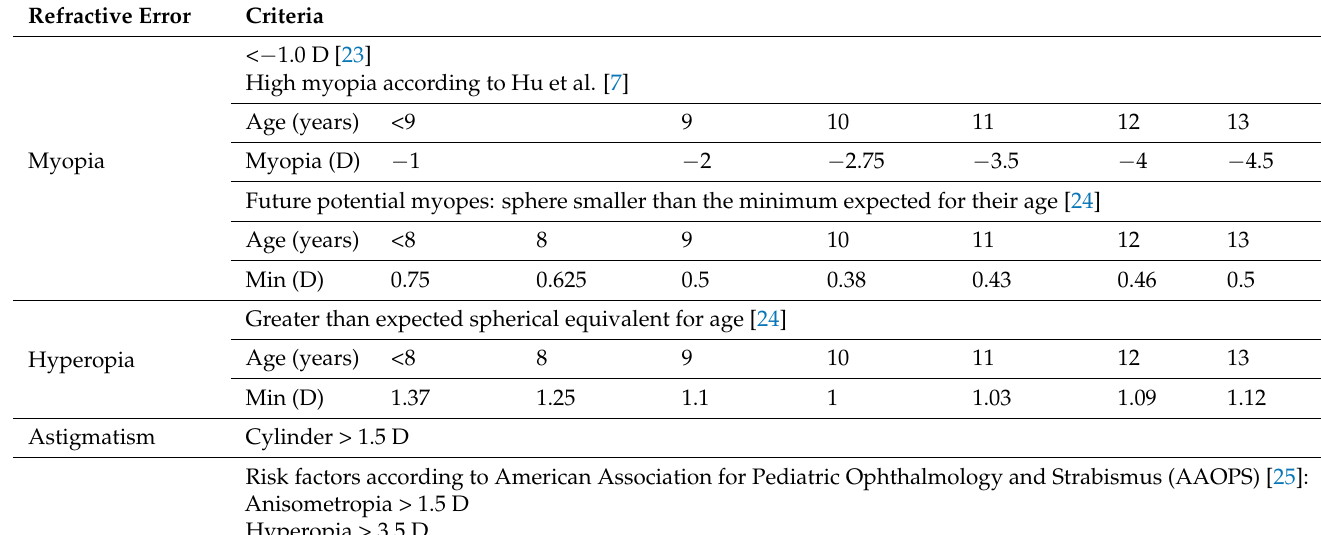
Table 1. Criteria used to classify refractive